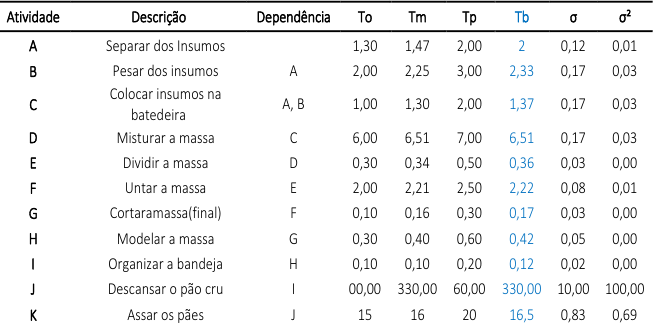
Tabela 1: Tabela de atividades, dependências, tempos, desvio padrão e variância.